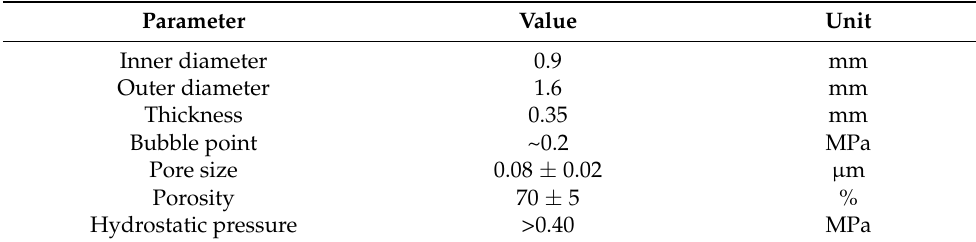
Table 1. Membrane specifications of the STOMMATE ® hollow fiber. Parameter Value Inner